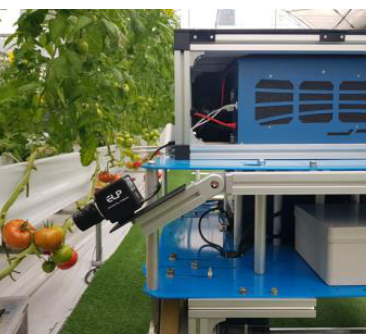
Figure 2. The schematic and the actual image of the monitoring robot.